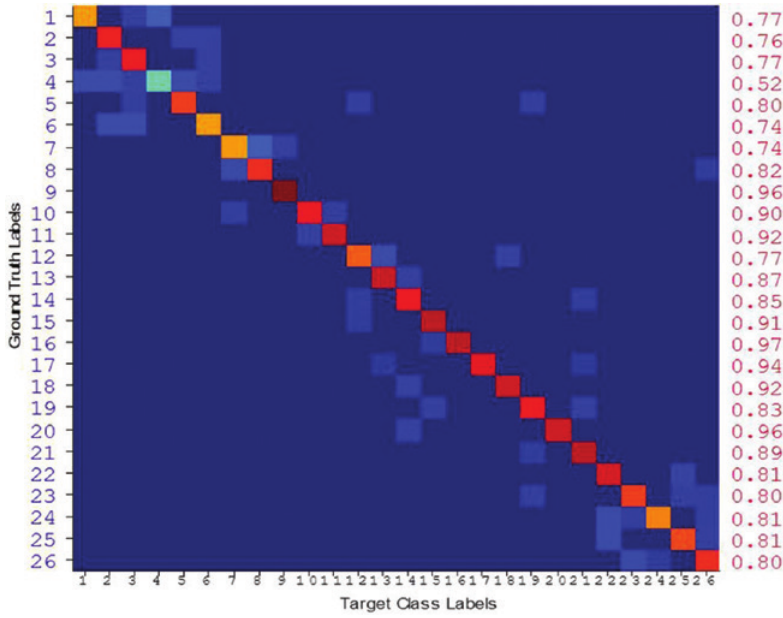
Figure 6: Confusion Matrix Obtained for (40:60) Training and Testing Samples.